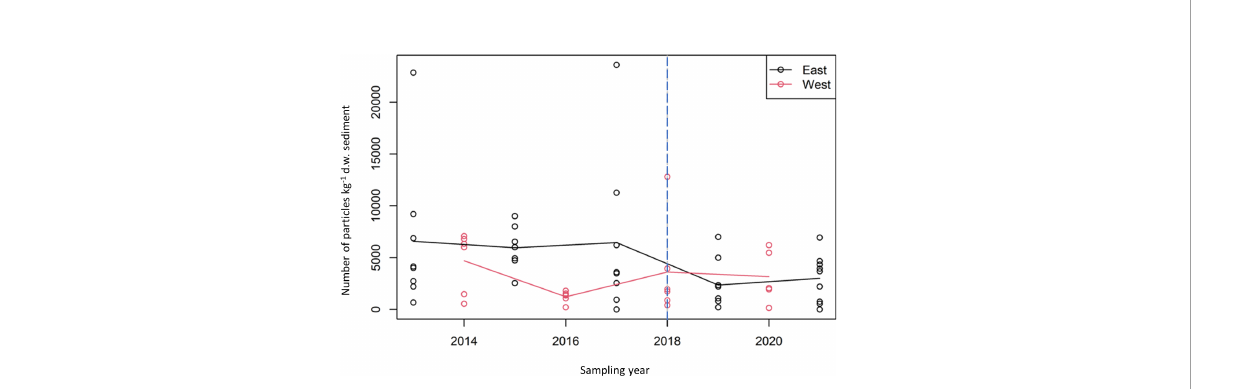
FIGURE 4 Mean particles kg -1 d.w. sediment plotted against year for East (black) and West (red) survey data. Also shown are lines linking the means of the square root counts for each of the two surveys. The vertical blue line at 2018 indicates the change in sampling method from the use of archive samples to dedicated microplastic